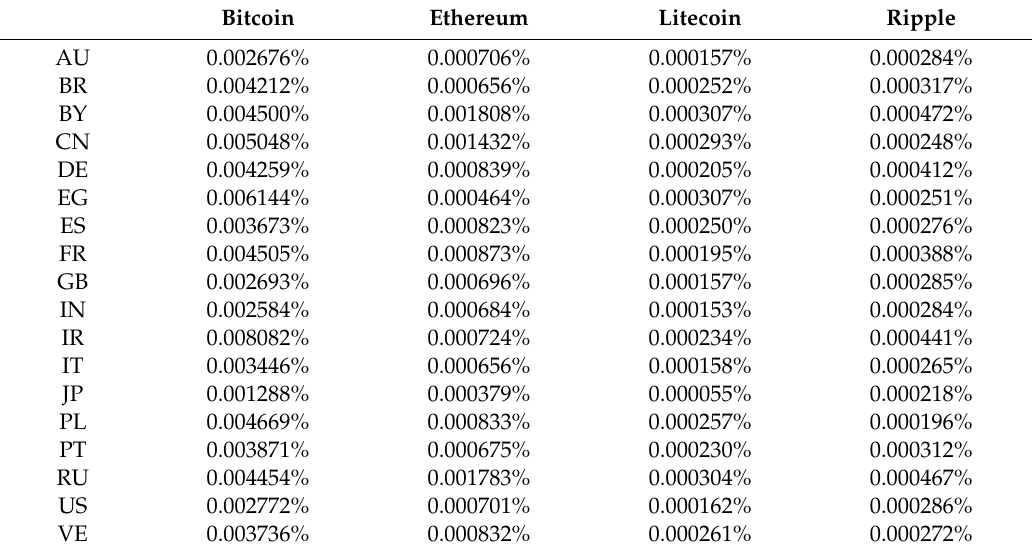
Table 10. Pageviews of four most important cryptocurrencies for selected countries over the